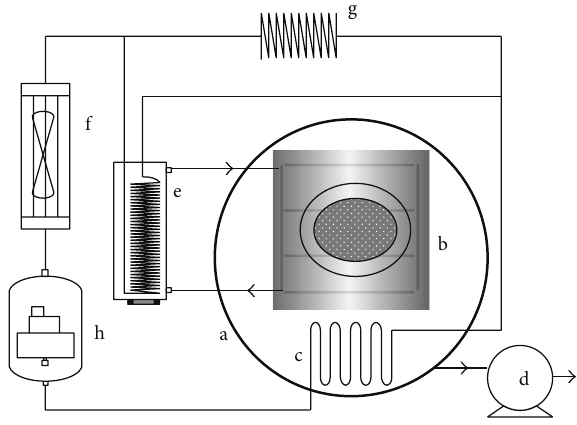
Figure 1: Schematic drawing of the freeze-drying